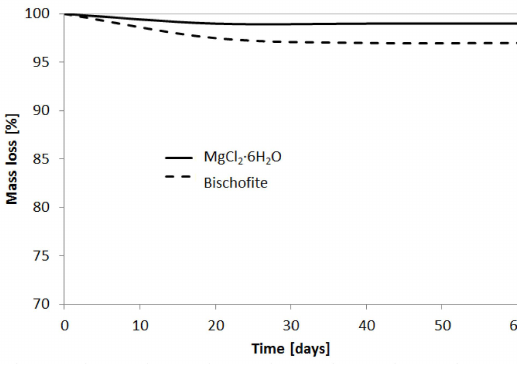
Figure 5. Mass loss of acrylic in contact with PCM.